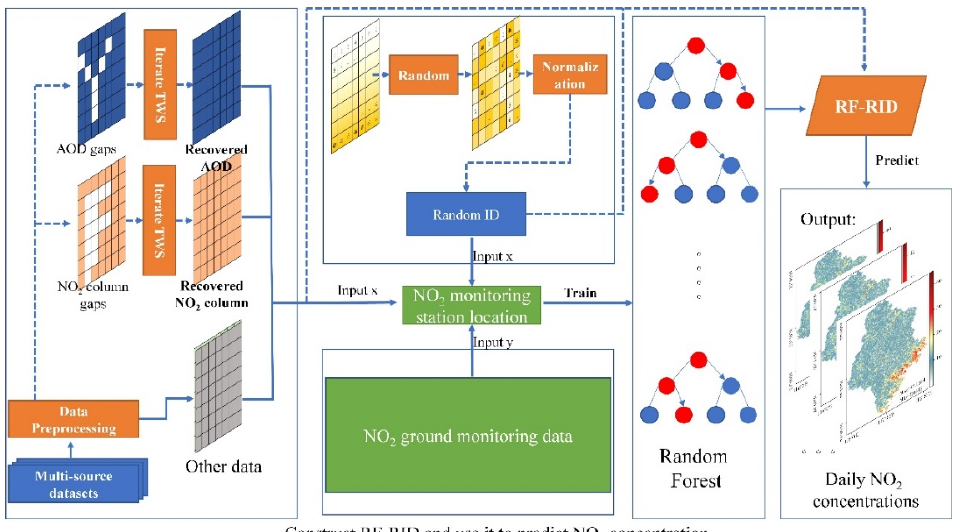
Figure 2. The flowchart for predicting NO 2 concentration using RF–RID. The iterated TWS recovered the AOD and NO 2 gaps. Multi-source and NO 2 -monitoring data are used as the basis for modeling. All the data are used for predicting the spatial distribution of NO 2 concentrations. Random ID is also used in the modeling and predicting process.